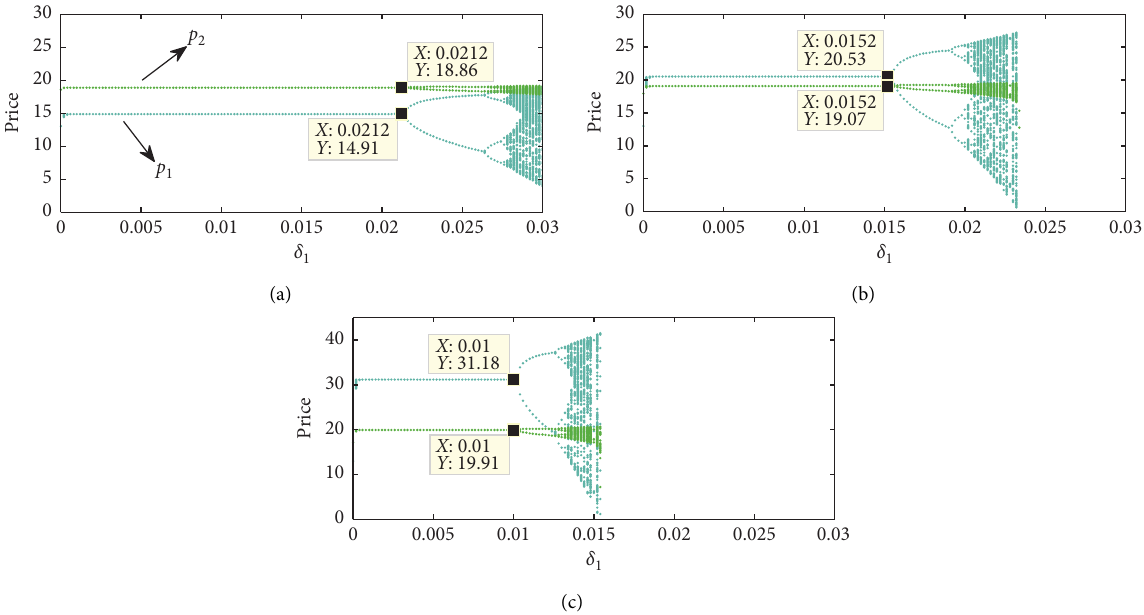
Figure 10: The bifurcation diagrams of dynamic system (15) with δ